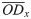
Diagnostic performance of the selected antigenic extract.Enzyme Lynked Immunosorbent Assay reactivity using the membrane amastigote extract against ATL and non-ATL cases sera Aand B, and excluding Chagatest reactive samples, C and D. The relation OD¯x / CO, where OD¯x is the average of duplicate or triplicate ODs for each sample tested, and CO = Cut-off. The indetermination area (IA) is shown in dotted line, and defined as CO / CO±10%CO / CO = 0,9–1,1. B and D show the Receiver Operating Characteristic (ROC) Curves for ELISAs.